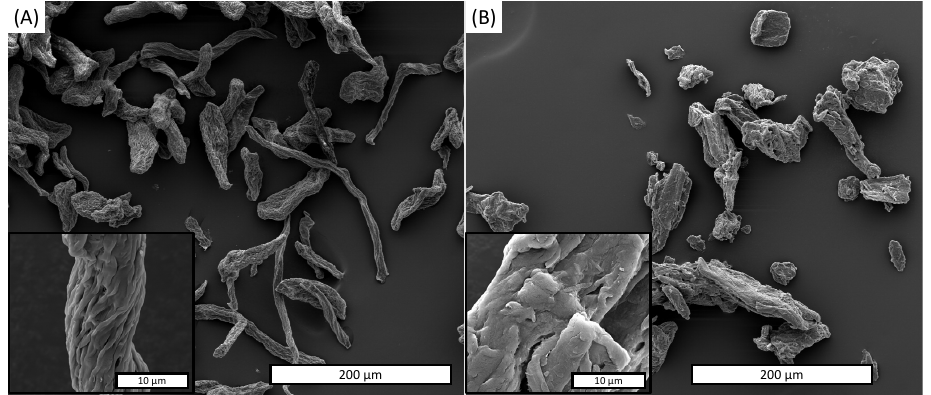
Figure 4. SEM image of ( A ) as-MCC and ( B ) c-MCC particles.